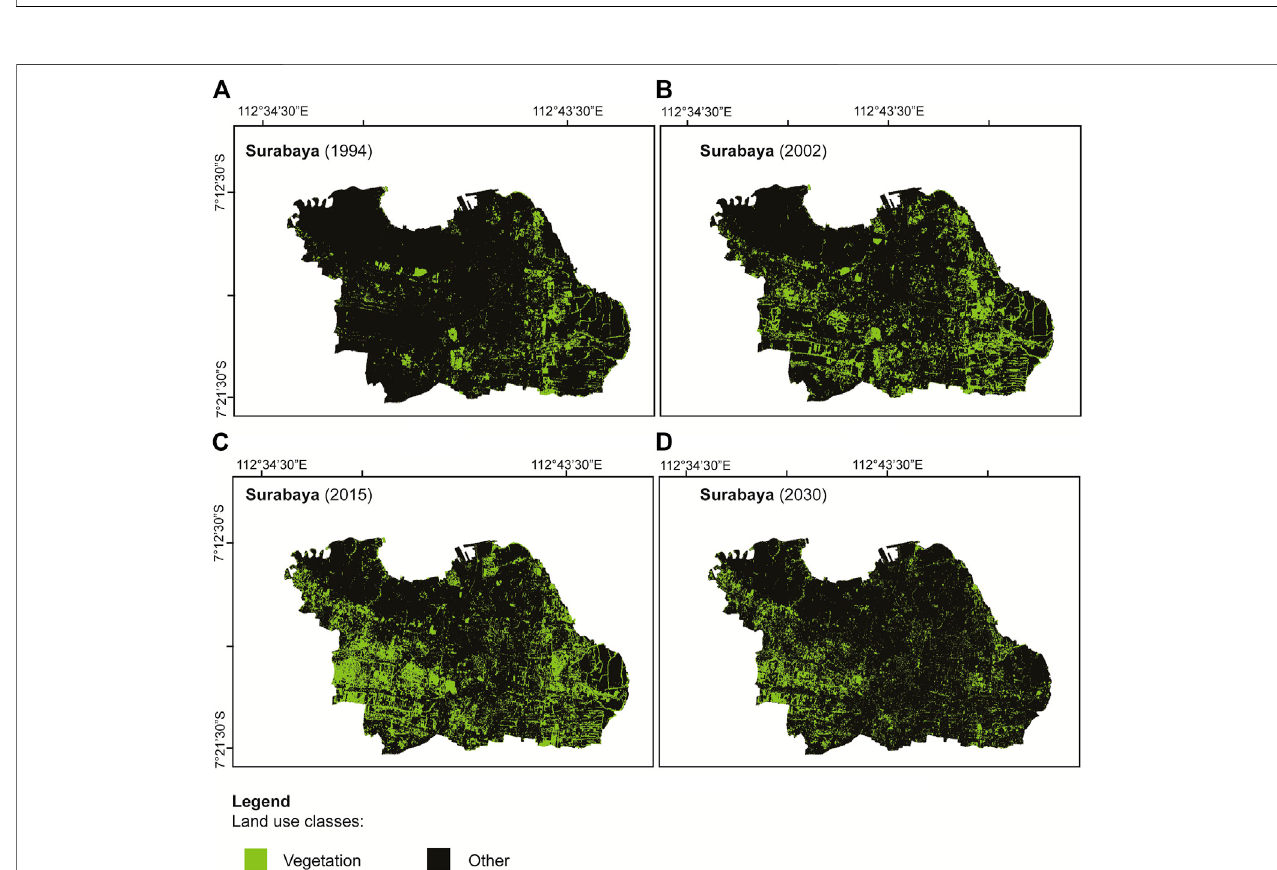
FIGURE 7 | Vegetation coverage change in Surabaya, (A) (1994), (B) (2002), (C) (2015), and (D) (2030).